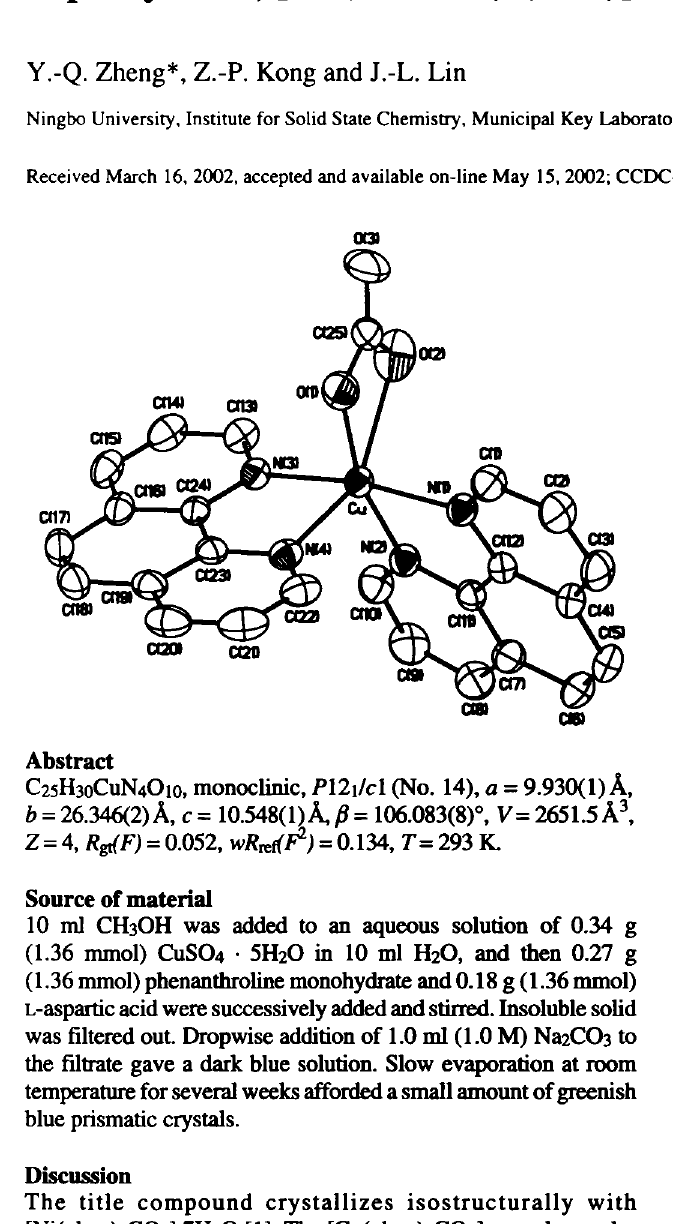
Table 1. Data collection and handling.